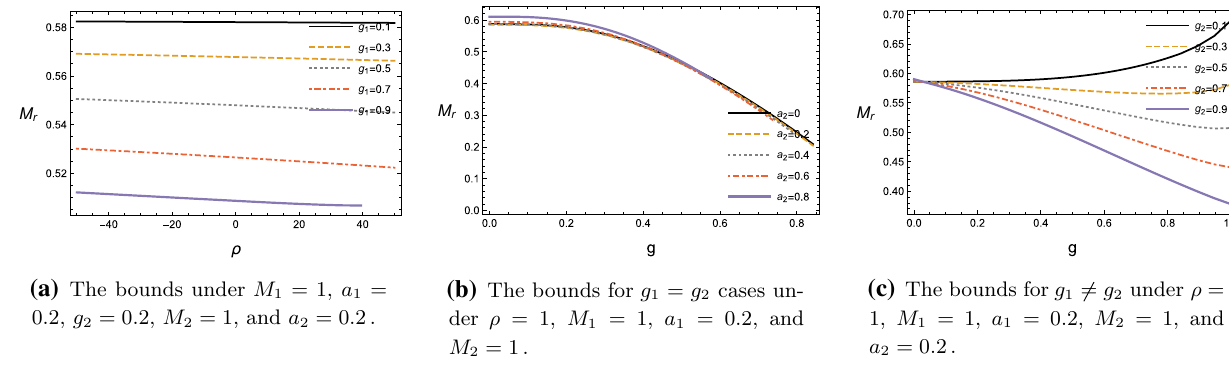
( a ) The bounds under ρ = 1, g 1 = 0 . 2, M 1 = 1, a 1 = 0 . 2, and g 2 = 0 . 2. Fig. 16 The upper bounds on the radiation in nonlinear electrodynamics g g